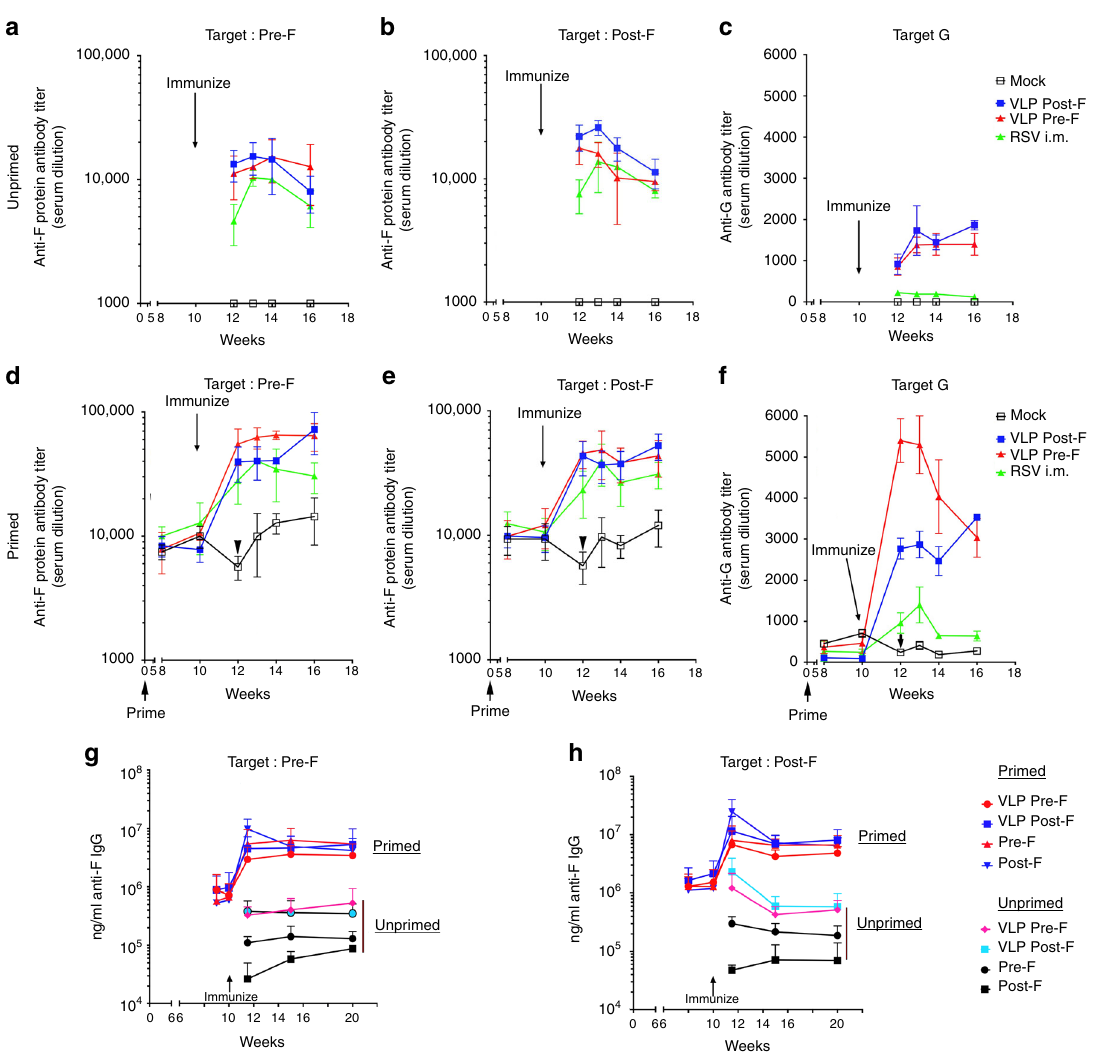
Fig. 4 Total IgG antibodies speci fi c for RSV pre-F, post-F, and G proteins generated by VLP immunization. Serum samples in each group at each time point during the experiment were pooled. Top row shows total IgG speci fi c for soluble pre-F ( a ), post-F ( b ), or G ( c ) proteins in serum from animals that were unprimed and vaccinated as indicated. Middle row shows total IgG speci fi c for soluble pre-F ( d ), post- F ( e ), or G ( f ) proteins in serum samples from animals that were RSV primed and vaccinated as indicated. Results show the average of 3 – 5 separate determinations. Arrowheads in mock-vaccinated animals depict the drop in total RSV-speci fi c IgG antibodies measured in serum samples collected before the time of delivery. p- values for week 13 serum antibody levels are shown in Supplementary Fig. 7. Bottom row shows total IgG speci fi c for soluble pre-F ( g ), or post-F ( h ) in serum samples from animals that were either RSV unprimed or primed and vaccinated as indicated. Results show the mean ± SD of 3 – 5 separate ELISA assays using a new pool serum samples from each lung (Fig. 5b), whereas none of the litters born to dams vacci- Litters born to unprimed or primed female cotton rats vaccinated nated i.m. with the puri fi ed F proteins (pre-F or post-F) or with with different VLPs, soluble F proteins, or RSV i.m. were chal- live RSV achieved that level of protection. No signi fi cant differ- lenged with RSV to evaluate the degree of protection remaining at ence in protection between pups of RSV-primed, pre-F, or post-F 4 weeks of age. A small but signi fi cant reduction (ANOVA fol- VLP-vaccinated dams was observed (Fig. 5b). lowed by Tukey post hoc test; + p = 0.0001) in viral titers in the Protection of the nose by VLP vaccinations was more modest lungs was seen in all litters born to unprimed dams vaccinated than protection of the lungs (Fig. 5c). However, two litters born to with VLPs or with RSV i.m. compared to pups of unprimed, RSV-primed dams immunized with pre-F VLP had signi fi cantly mock-vaccinated dams (Fig. 5b, black symbols). However, no reduced levels of virus in their noses compared to litters born to differences in protection were seen between groups born to primed dams immunized with puri fi ed pre-F or post-F (Fig. 5c). unprimed, mock-vaccinated dams, and litters born to dams vaccinated with puri fi ed F proteins. In contrast, vaccination of Lung pathology and in fl ammatory cytokines in litters post primed dams with VLPs or puri fi ed F proteins signi fi cantly challenge . Next we examined whether vaccination of female improved protection of their litters (Fig. 5b, red symbols) from cotton rats during pregnancy with VLPs could also bene fi t the RSV challenge, while live RSV i.m. immunization did not. In litter by decreasing the lung pathology associated with primary VLP-vaccinated groups, some litters showed full protection of the RSV infection. Hematoxylin and eosin-stained lung sections were